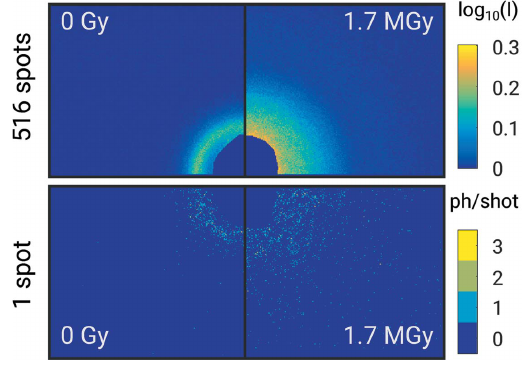
Figure 1 Diffraction patterns taken from PNIPAM. Top: averaged signals of 516 single shots on fresh sample spots (0 Gy) and after exposure to 119 shots corresponding to 1.7 MGy. Bottom: the same for single